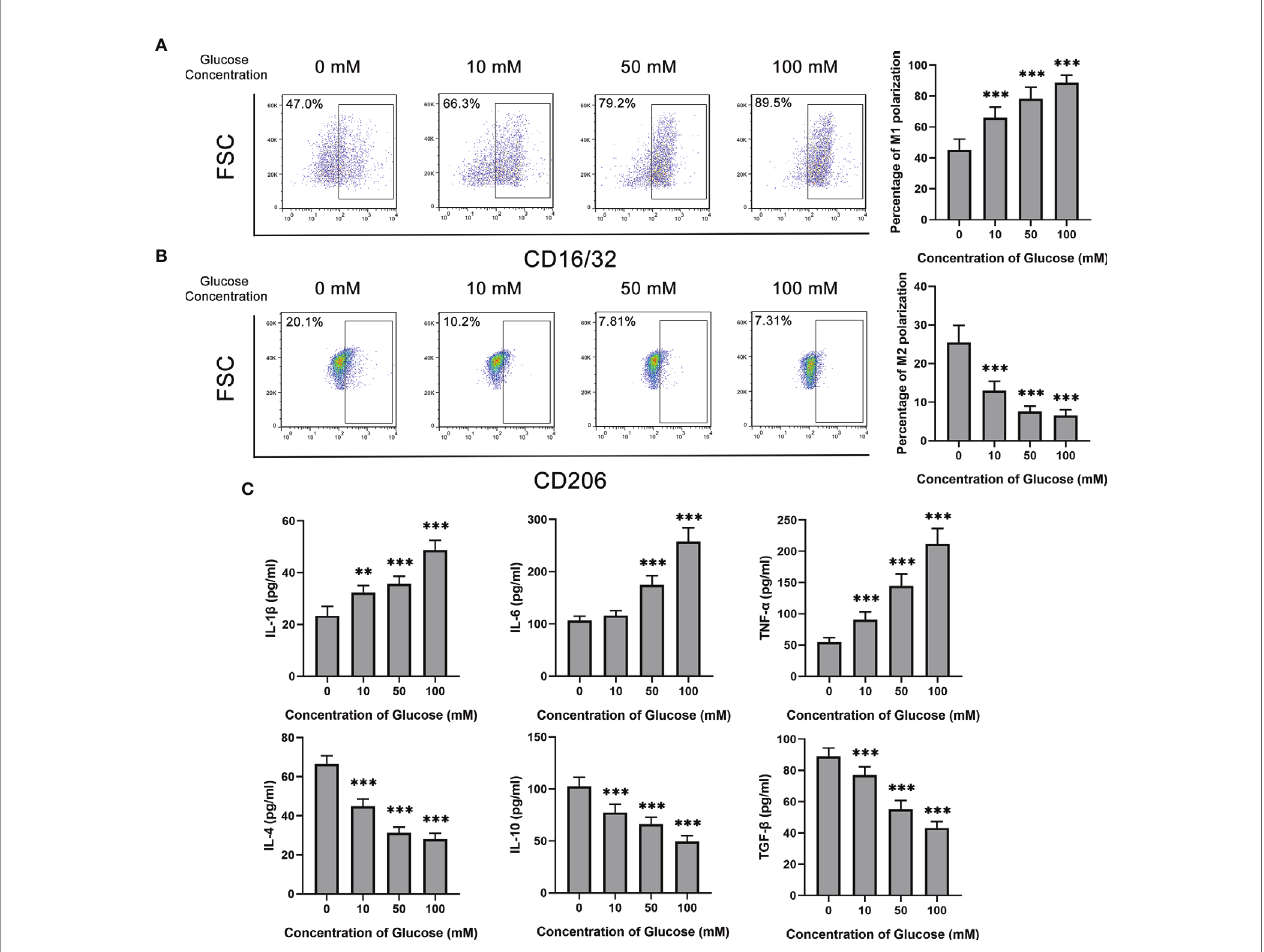
FIGURE 2 | Glucose promoted M1 polarization but inhibited M2 polarization of microglia. (A) The percentage of CD16/32 + M1 microglia gradually increased with glucose treatment from the concentration of 0 to 100 mM. (B) The percentage of CD206 + M2 microglia gradually decreased with glucose treatment from the concentration of 0 to 100 mM. (C) The secretion levels of IL-1 b , IL-6 and TNF- a up-regulated with the increase of glucose concentration, and the secretion levels of IL-4, IL-10 and TGF- b down-regulated with the decrement of glucose concentration. Values are presented as the mean ± SD. ** indicates P < 0.01, and *** indicates P <